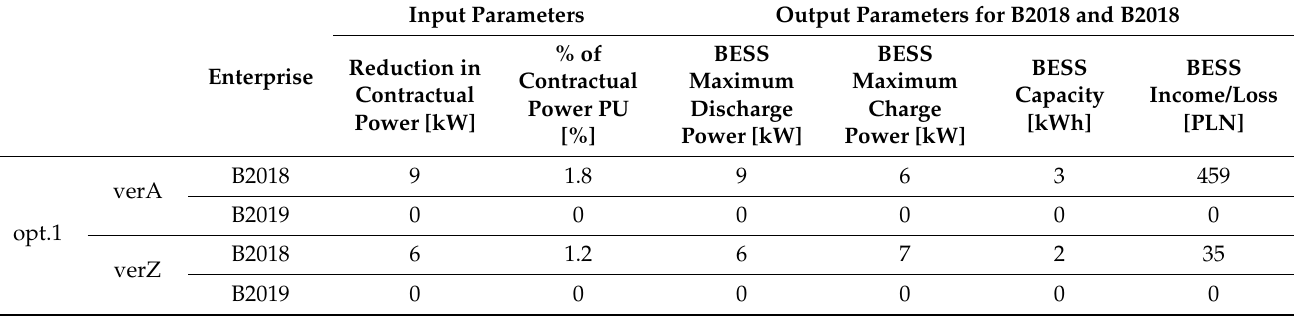
Table 4. Numerical results of the simulation of the peak shaving strategy for enterprise B2018 and